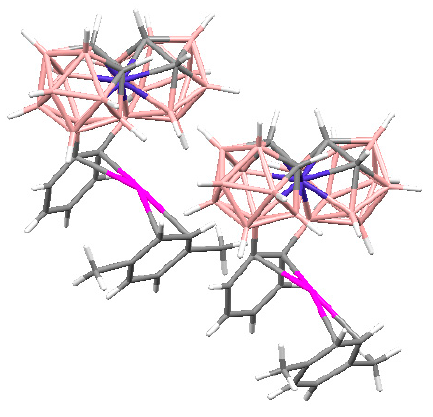
Figure 101. X-ray structure of {Ag( η 2 - p -xylene)[8,8’- μ -C 6 H 4 -3,3’-Co(1,2-C 2 B 9 H 10 ) 2 ]}. Complex {((MeCN) 2 Ag)[3,3’-Co(1,2-C 2 B 9 H 11 ) 2 ]} n was obtained by crystallization of Ag[3,3’-Co(1,2-C 2 B 9 H 11 ) 2 ] from an acetonitrile/2,2,2-trifluoroethanol solution. The silver cation is